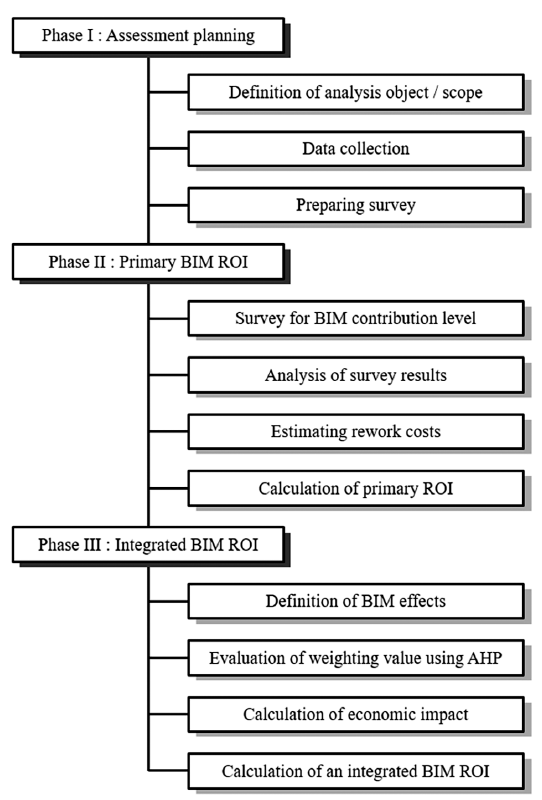
Figure 1. Phases in the proposed